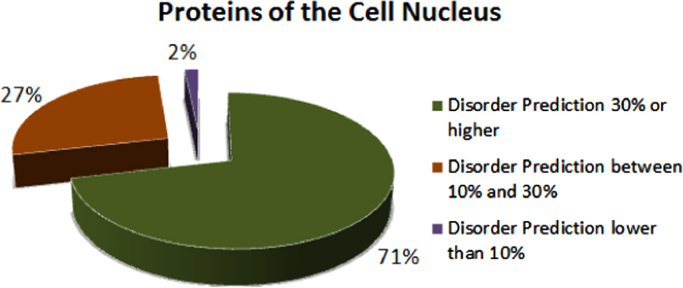
Peculiarities of disorder distribution in human nuclear proteins.